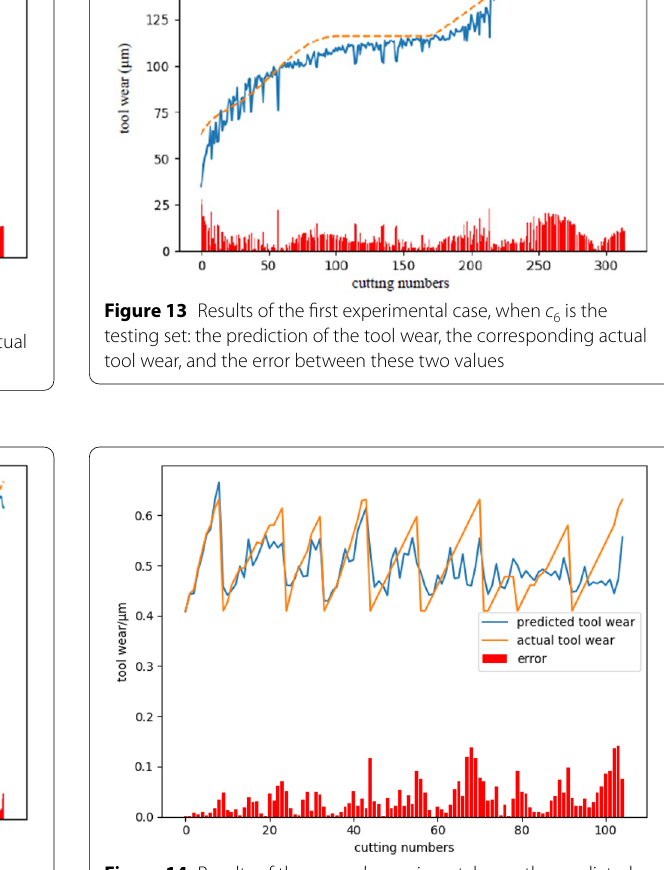
Figure 12 Results of the first experimental case, when c 4 is the testing set: the prediction of the tool wear, the corresponding actual tool wear, and the error between these two values